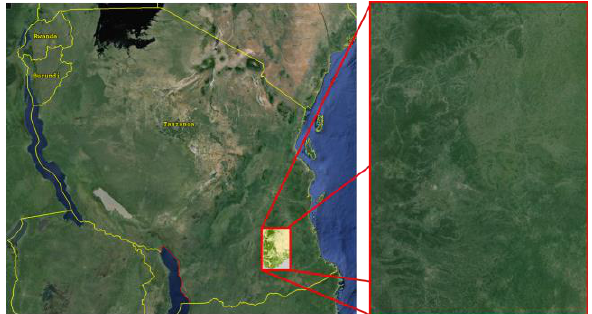
Figure 1. The location of the Liwale study site in Tanzania (©